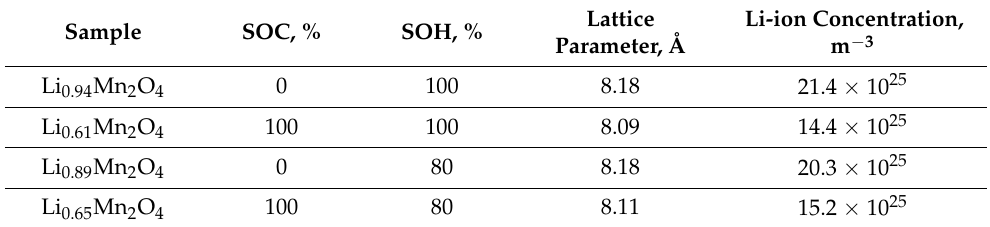
Table 1. The parameters of the LMO-based